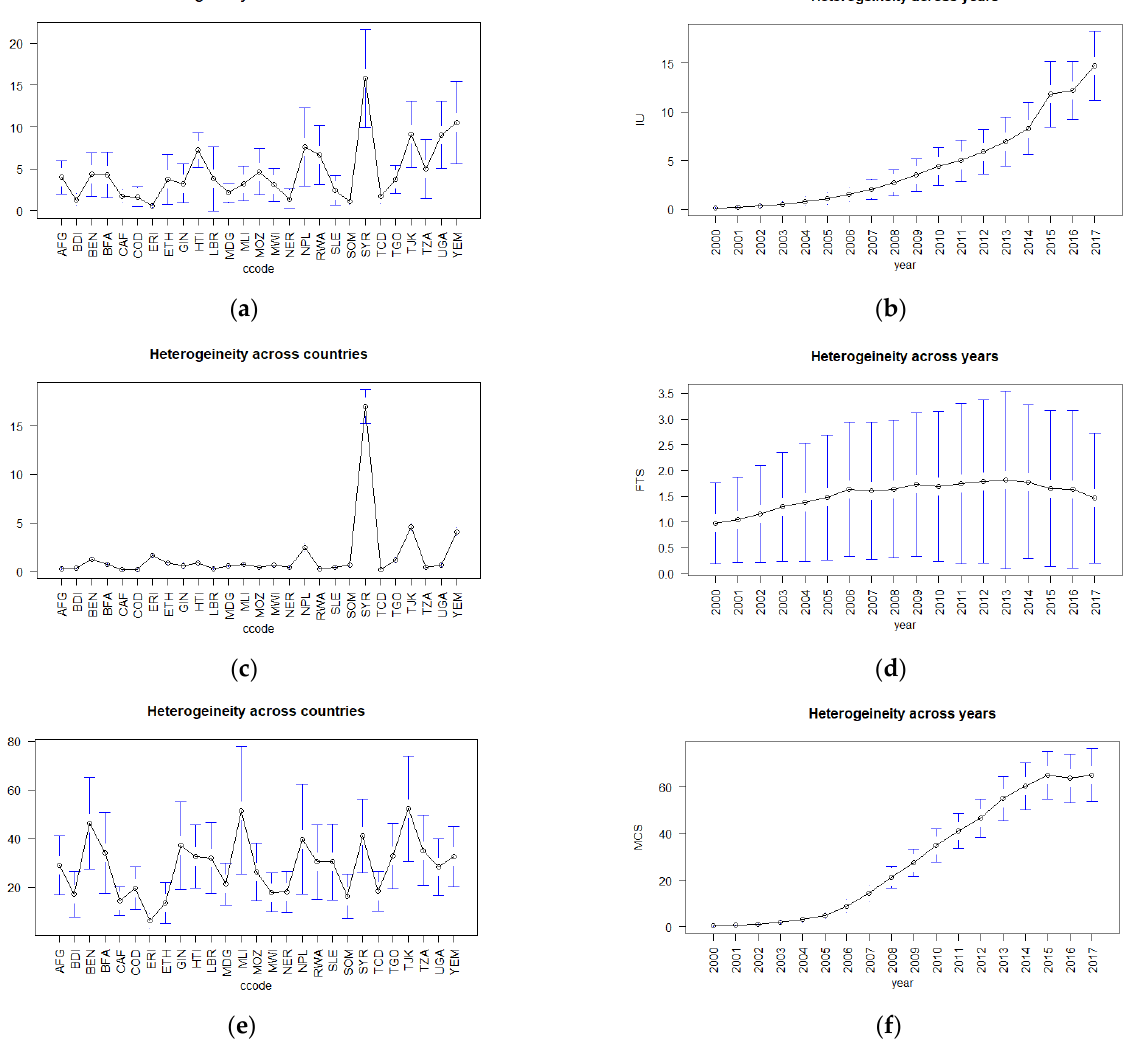
Figure 2. The time and year heterogeneity for the independent variables: IU heterogeneity ( a ) across countries and ( b ) across years; FTS heterogeneity ( c ) across countries and ( d ) across years; MCS heterogeneity ( e ) across countries and ( f ) across years.